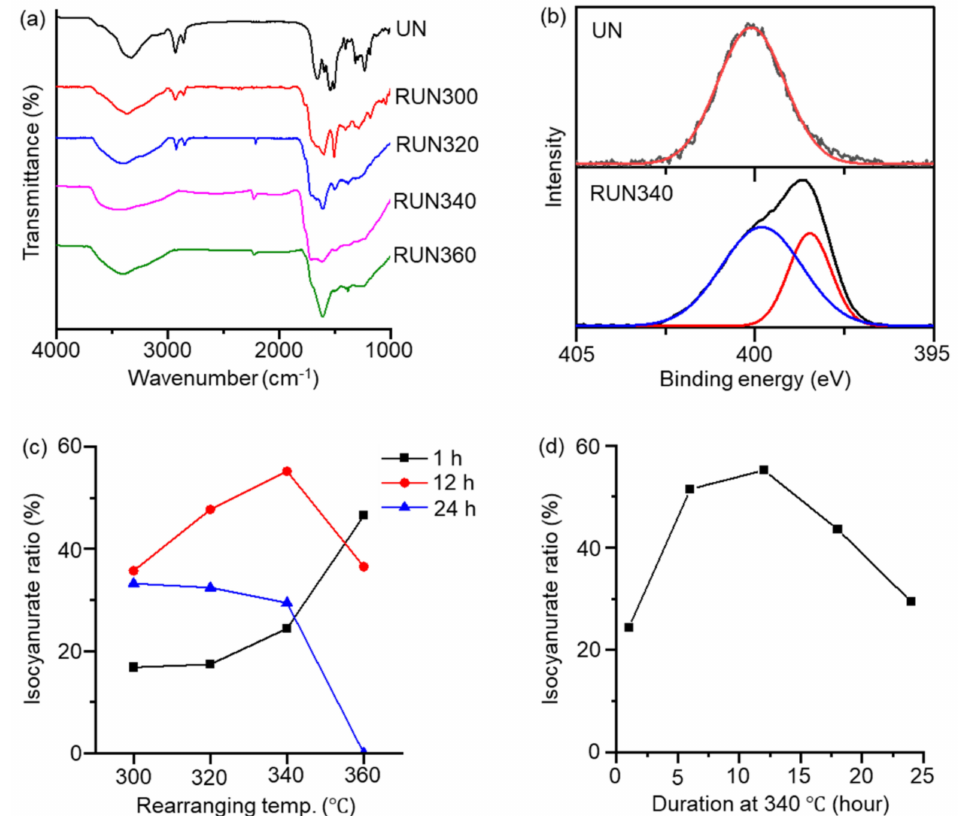
Figure 2. Chemical compositions of the RUNs varying with the thermal treatment conditions. ( a ) FT-IR spectra of the RUNs treated at different final temperatures for 12 h. ( b ) XPS N1’s spectra of the UN and RUN340. ( c ) Isocyanurate ratio of RUNs prepared with different final temperatures for durations of 1, 12, and 24 h. ( d ) Isocyanurate ratio of RUN samples prepared for different durations at 340 ◦